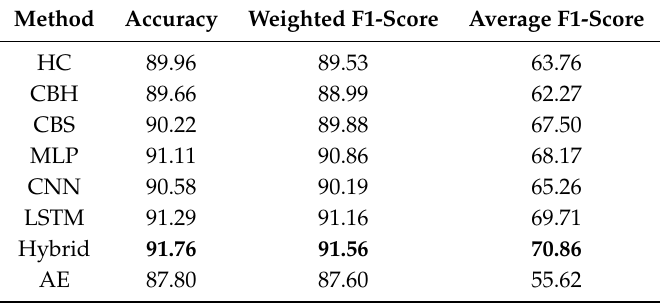
Table 5. Classification performance metrics (in percent) of different feature extraction models on the OPPORTUNITY